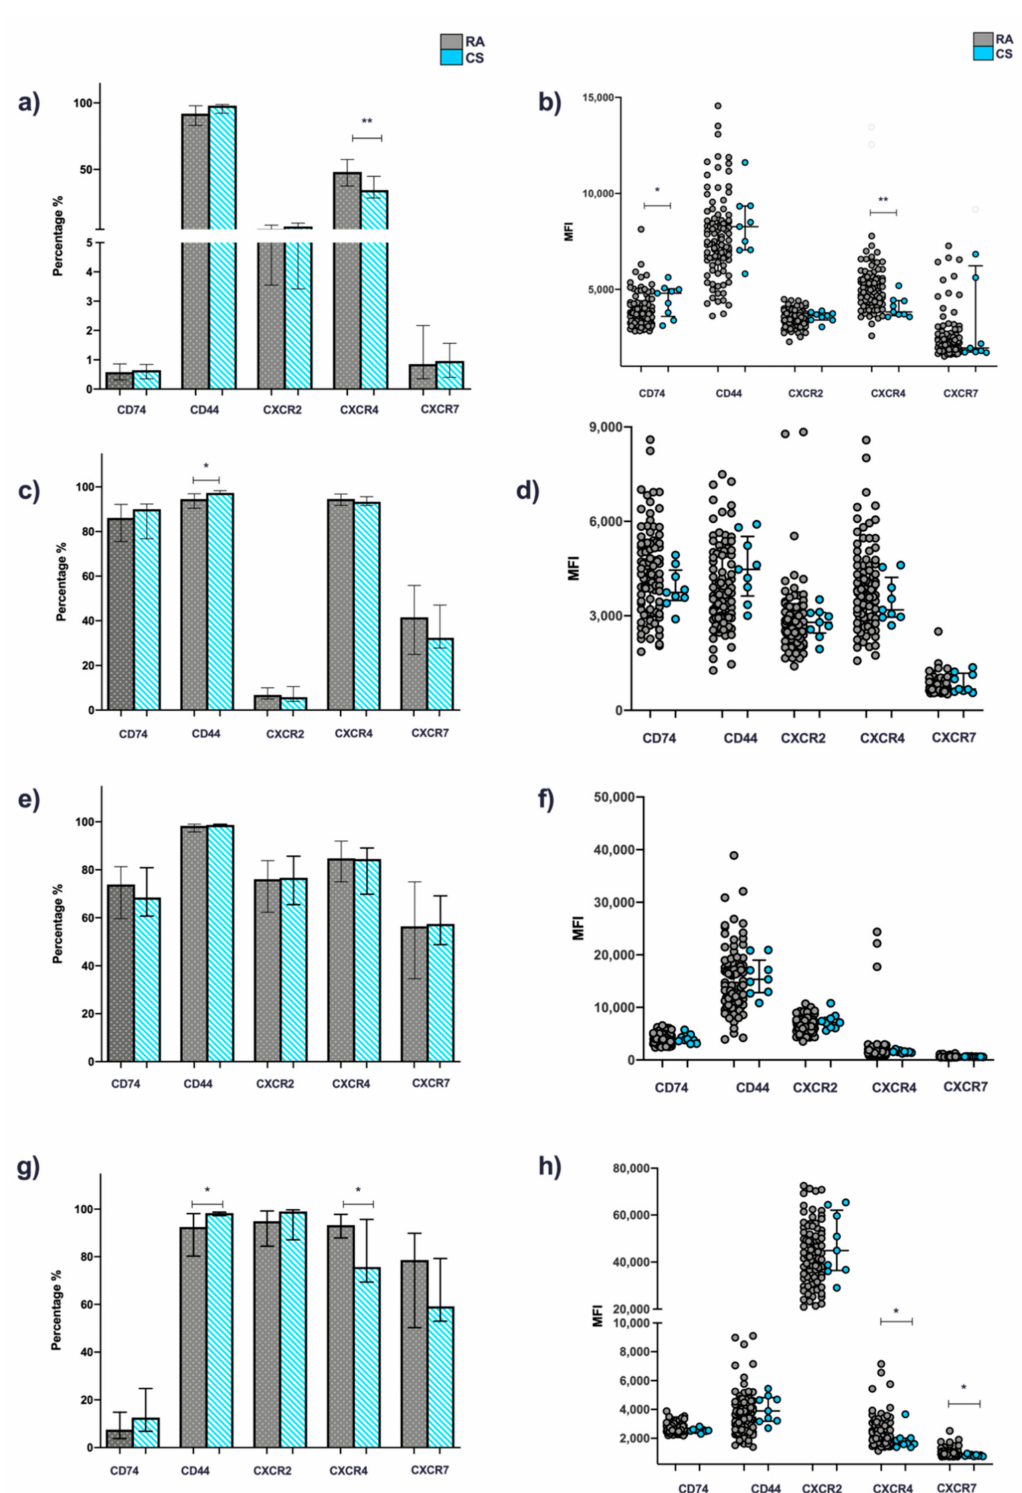
Figure 2. Expression of canonical (CD74/CD44) and non-canonical (CXCR2,4 and 7) MIF receptors in whole blood cells from patients with RA and CS. Percentage and MFI of cells positive for CD74, CD44, CXCR2, CXCR4 and CXCR7. T cells ( a ) and ( b ), B cells ( c ) and ( d ), monocytes ( e ) and ( f ) and granulocytes ( g ) and ( h ) of patients with RA ( n = 101) vs. SC ( n = 9). Statistical comparisons between groups were determined using the Mann–Whitney U test (AR vs. SC). * p < 0.05; ** p < 0.01. RA: rheumatoid arthritis; CS: control subjects; MFI: mean fluorescence